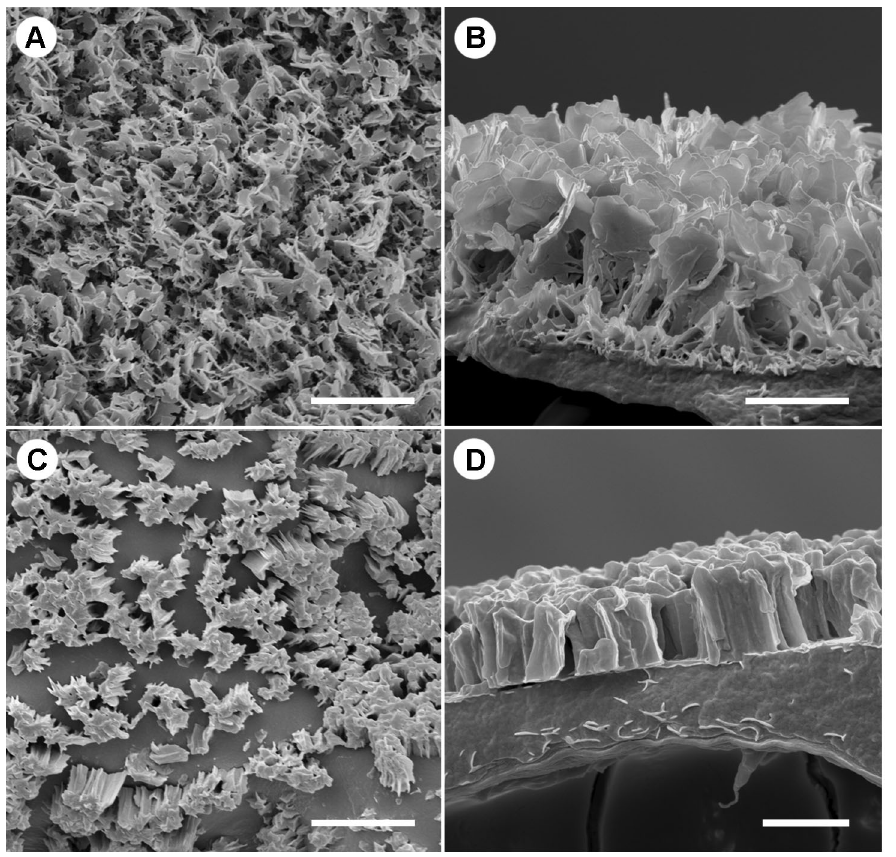
Figure 4. Microscopic structure of the wax crystal surfaces. (A–B) Microstructure of the crystalline wax layer on the inner pitcher wall. (A) Top view, showing a dense network of thin, upright wax platelets (scale bar: 5 m m). The freeze-fracture side view (B) reveals the internal organisation of the surface (scale bar: 2 m m). (C–D) Microstructure of the lower lid surface. (C) Top view: the wax crystals form solid, pillar-like structures, unevenly distributed across the surface and surrounded by smooth cuticle (scale bar: 5 m m). (D) Side view of the wax pillars (scale bar: 2 m m).